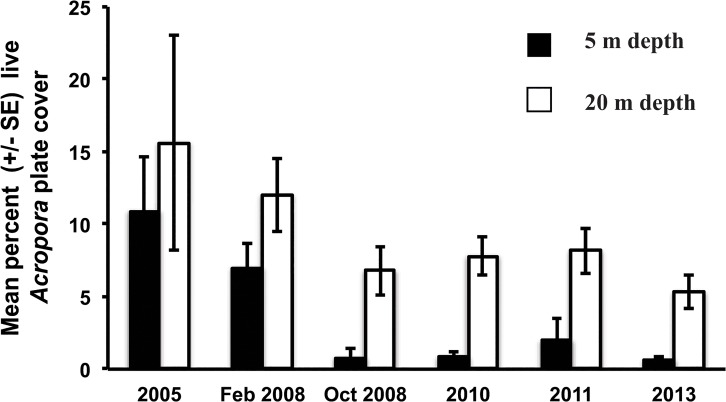
Mean percent live coral cover (± SE) of Acropora plate corals from 2005 to 2013.February 2008 represents the beginning of the White Syndrome outbreak and October 2008 represents the end of the outbreak. Values for 2005 are from [27], and are based on seven of the eight study sites surveyed from 2008 to 2013. Values are presented for 5 m (black bars) and 20 m (white bars) depths.